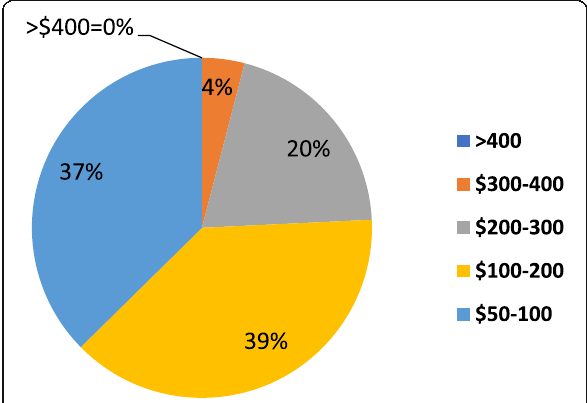
Fig. 5 Responses to question 12: Expected monthly cost of medical marijuana among those willing to consider it ( n = 204)